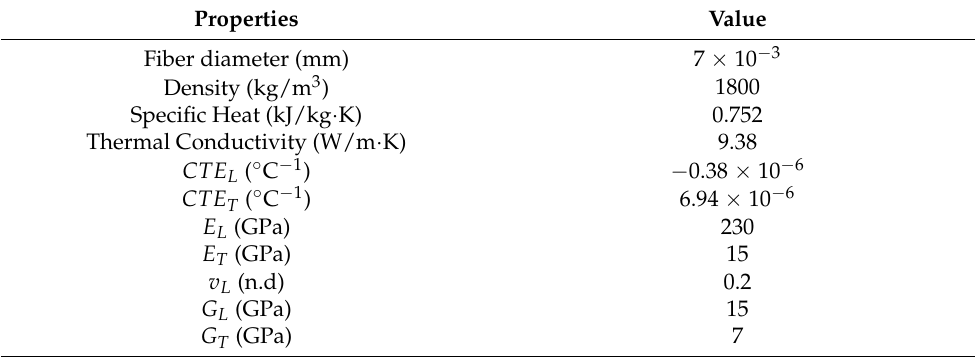
Table 1. Carbon fiber material properties.